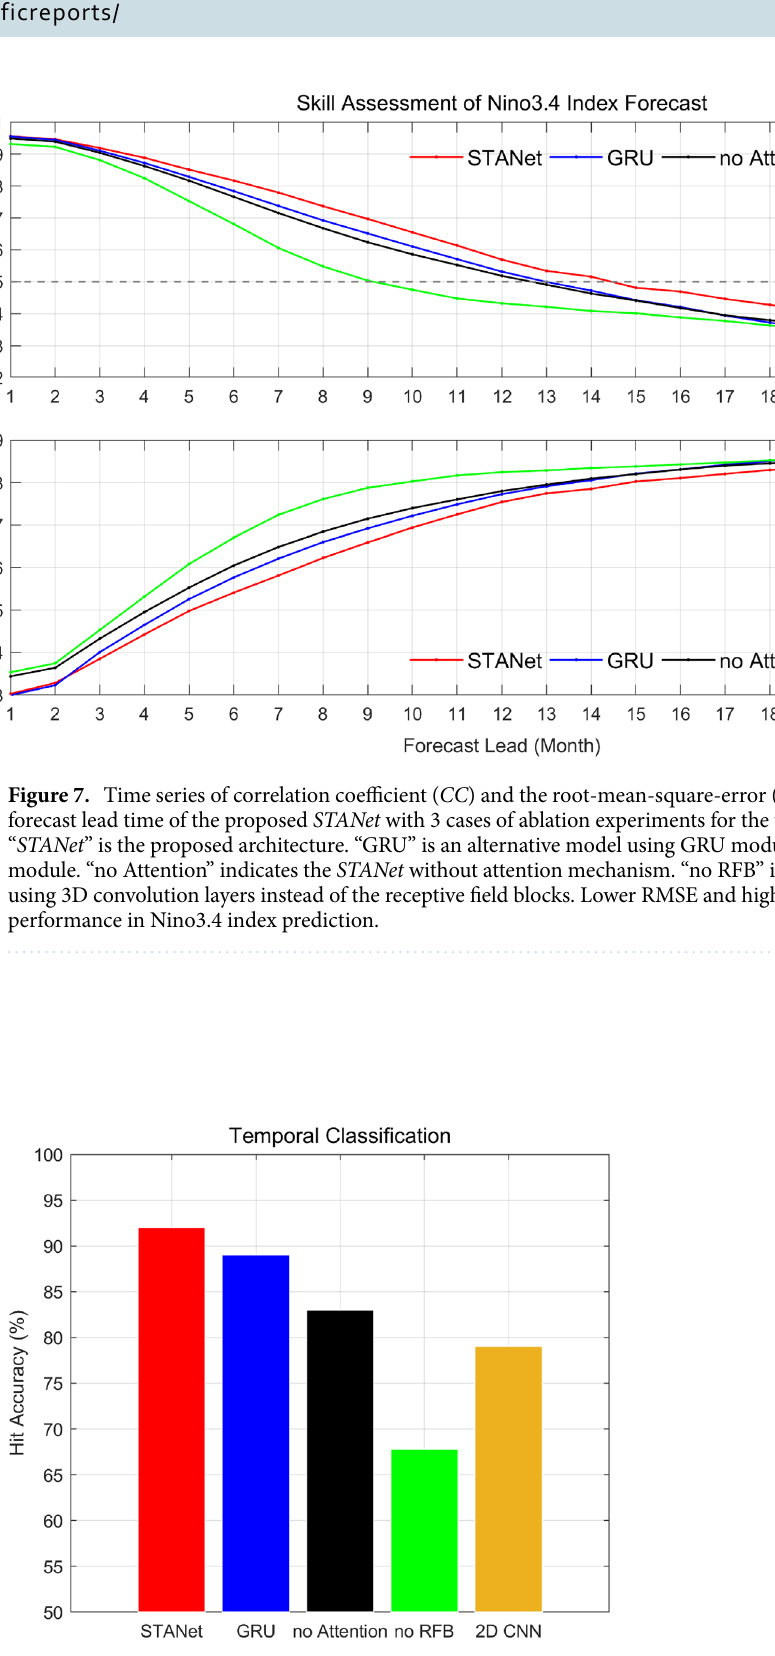
Figure 8. Hit accuracy for the calendar month classification for the proposed STANet with 3 cases of ablation experiments and the SOTA 2D CNN for the test period of 1980–2017. “ STANet ” is the proposed architecture. “GRU” is an alternative model using GRU module 29 instead of the LSTM module. “no Attention” indicates the STANet without attention mechanism. “no RFB” indicates the STANet using 3D convolution layers instead of the receptive field